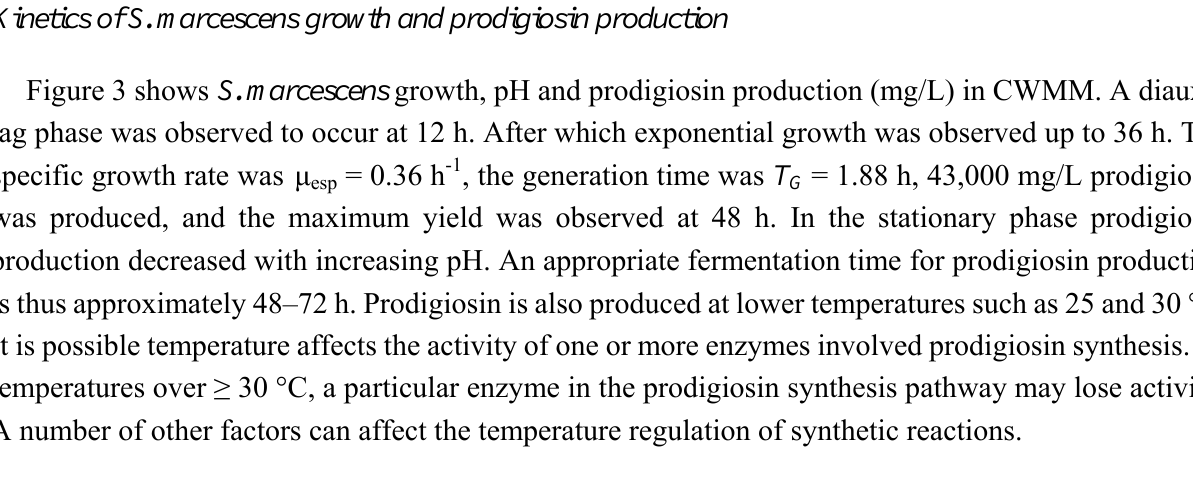
Figure 3. Growth kinetics, pH and prodigiosin production by S. marcescens in CWMM at 28 °C for 96